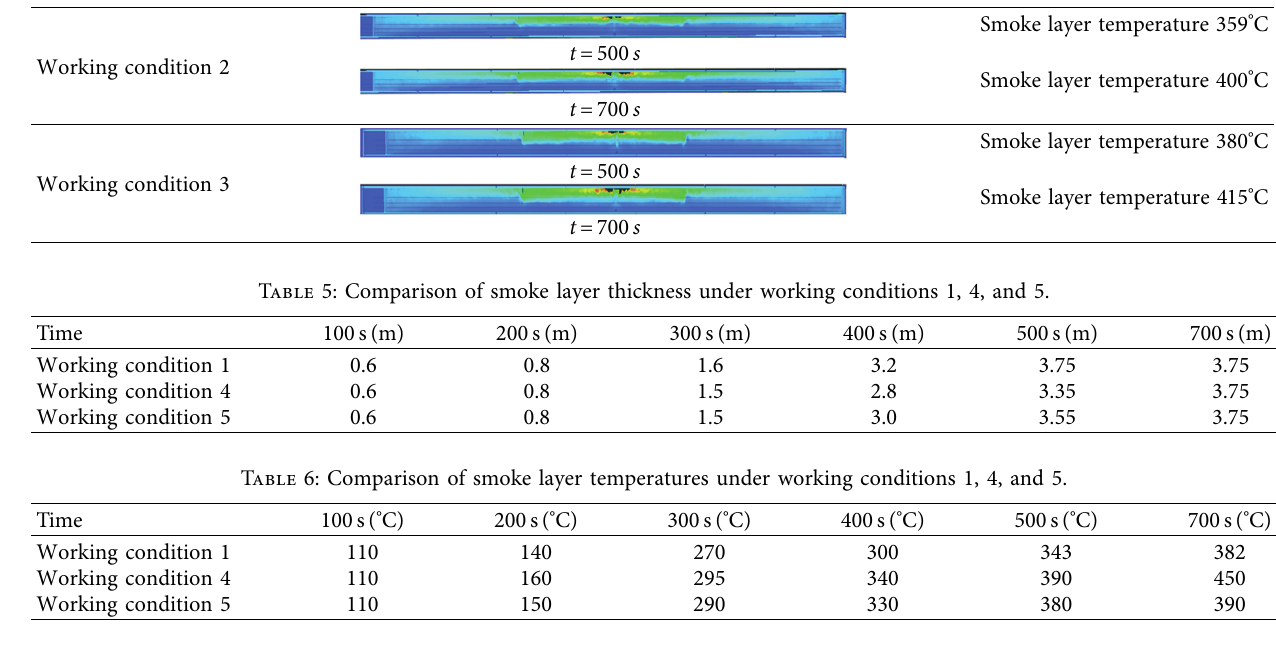
Table 7: Comparison of smoke spread under working conditions 1 and 6.